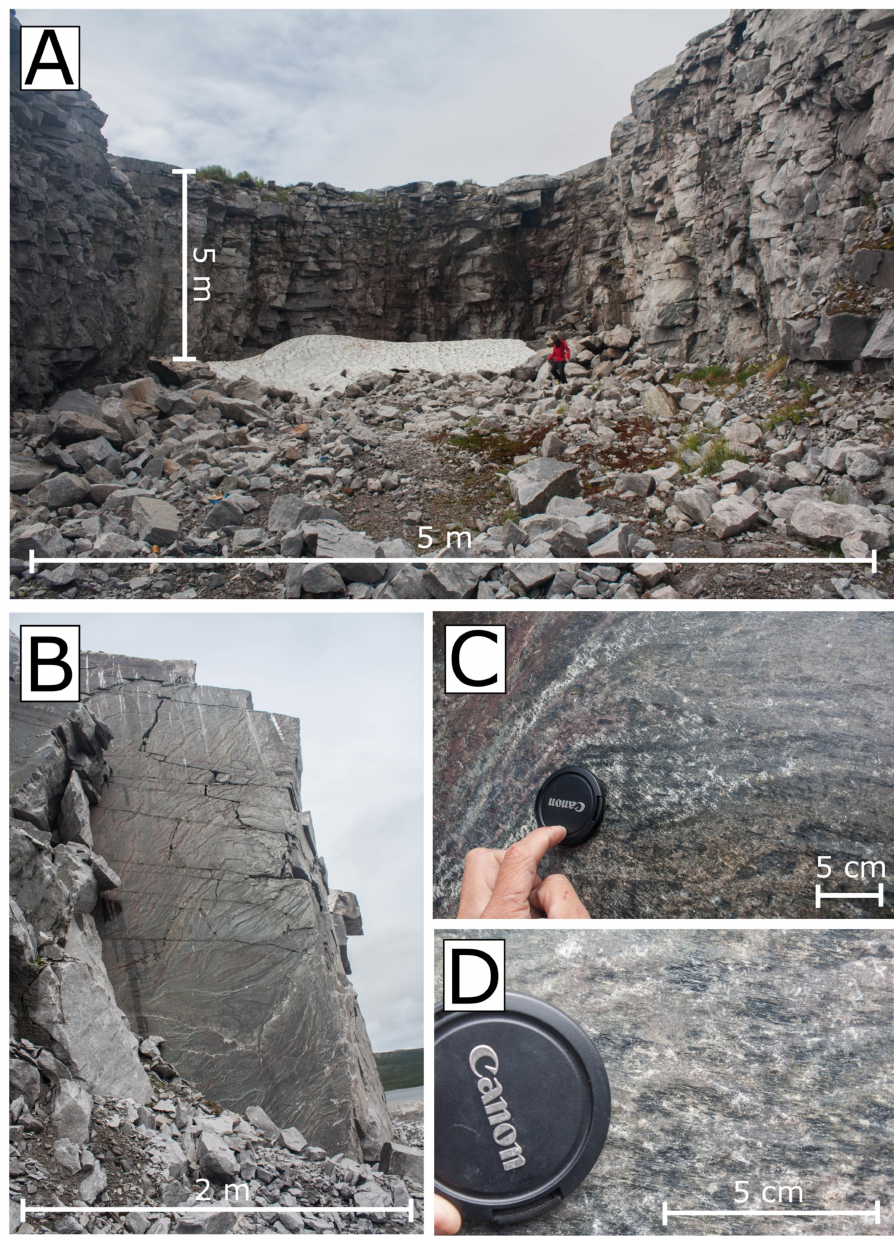
Figure 9. Examples of brittle deformation not associated with the epidote mineralisation that contributed to the data used in inversion A. The quarry near Makkovik shown on subfigure ( A ) located at 55.0756 ◦ N/59.169299 ◦ W contained multiple surfaces similar to those in subfigure ( B ) with readily observable slicken lines, such as those in subfigures ( C , D